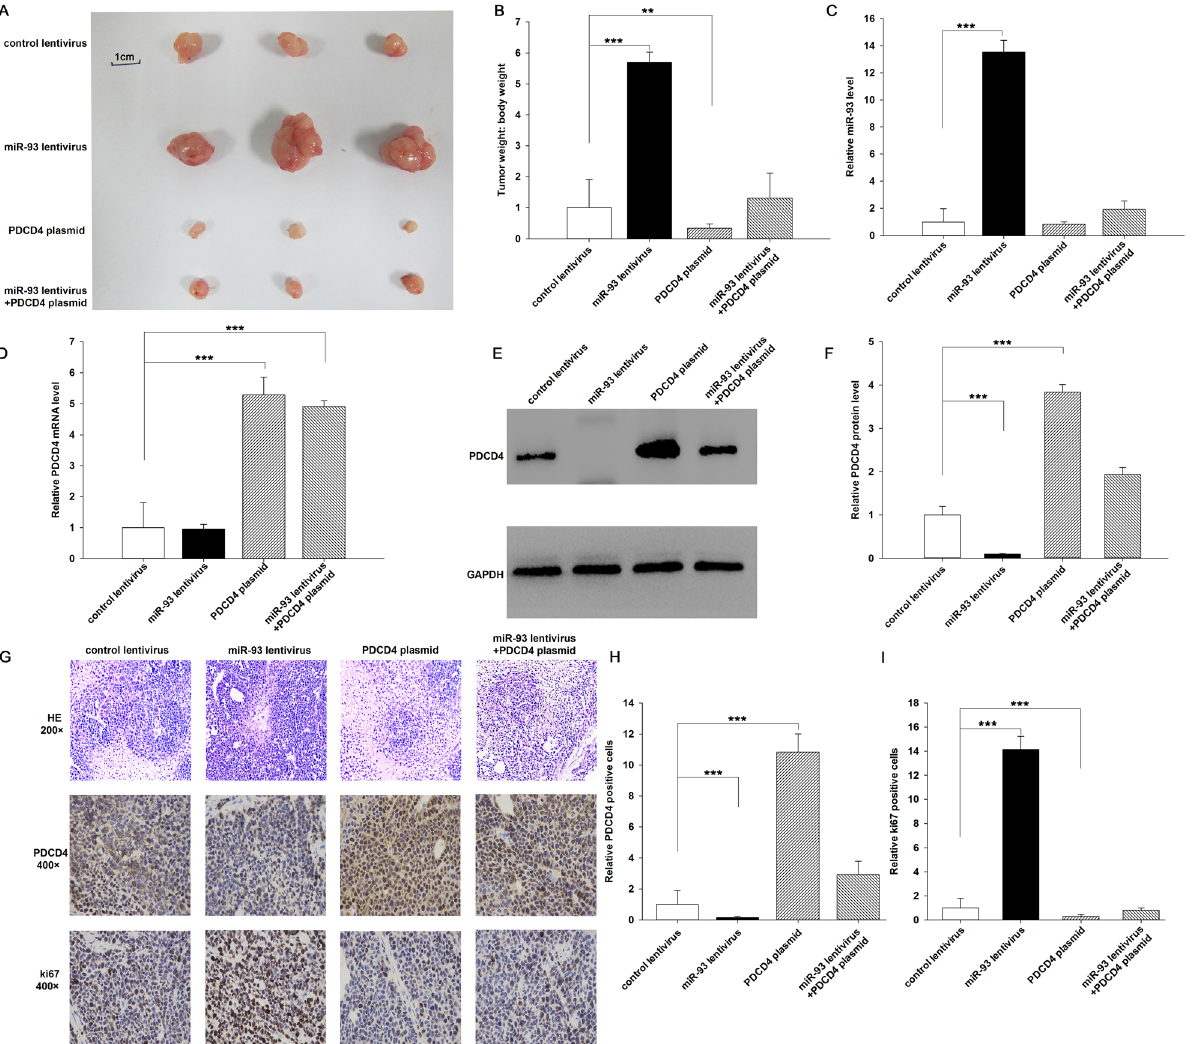
Figure 6. Effects of miR-93 and PDCD4 on the growth of gastric cancer cell xenografts in mice. AGS cells were infected with a control lentivirus or a miR-93 overexpression lentivirus, or transfected with a PDCD4 overexpression plasmid, or co-transfected with the miR-93 overexpression lentivirus plus PDCD4 overexpression plasmid. Then the cells (2 × 10 6 cells per 0.1 mL) were implanted subcutaneously into 6-week-old SCID mice (5 mice per group) and tumor growth was evaluated at day 60 after cell implantation. (A) Representative images of the tumors from the implanted mice. (B) Quantitative analysis of the tumor weights. (C) Quantitative RT-PCR analysis of miR-93 levels in the tumors from implanted mice. (D) Quantitative RT-PCR analysis of PDCD4 mRNA levels in the tumors from implanted mice. (E,F) Western blotting analysis of PDCD4 protein levels in the tumors from implanted mice. ( E ) representative image; ( F ) quantitative analysis. (G–I) H & E-stained sections and immunohistochemical staining for PDCD4 and Ki-67 in the tumors from implanted mice. ( G ) representative image; ( H , I ) quantitative analysis. **p < 0.01; ***p <